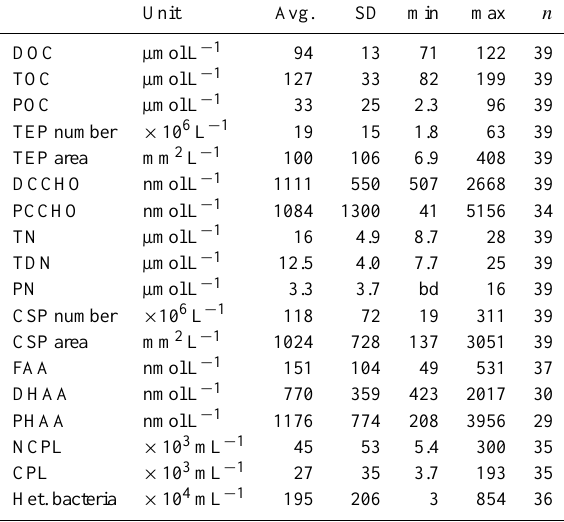
Table 2. Concentration of various organic components in the SML during M91, given as average (avg.) and standard deviation (SD), as well as minimum (min) and maximum (max); n = number of observations. For abbreviations see